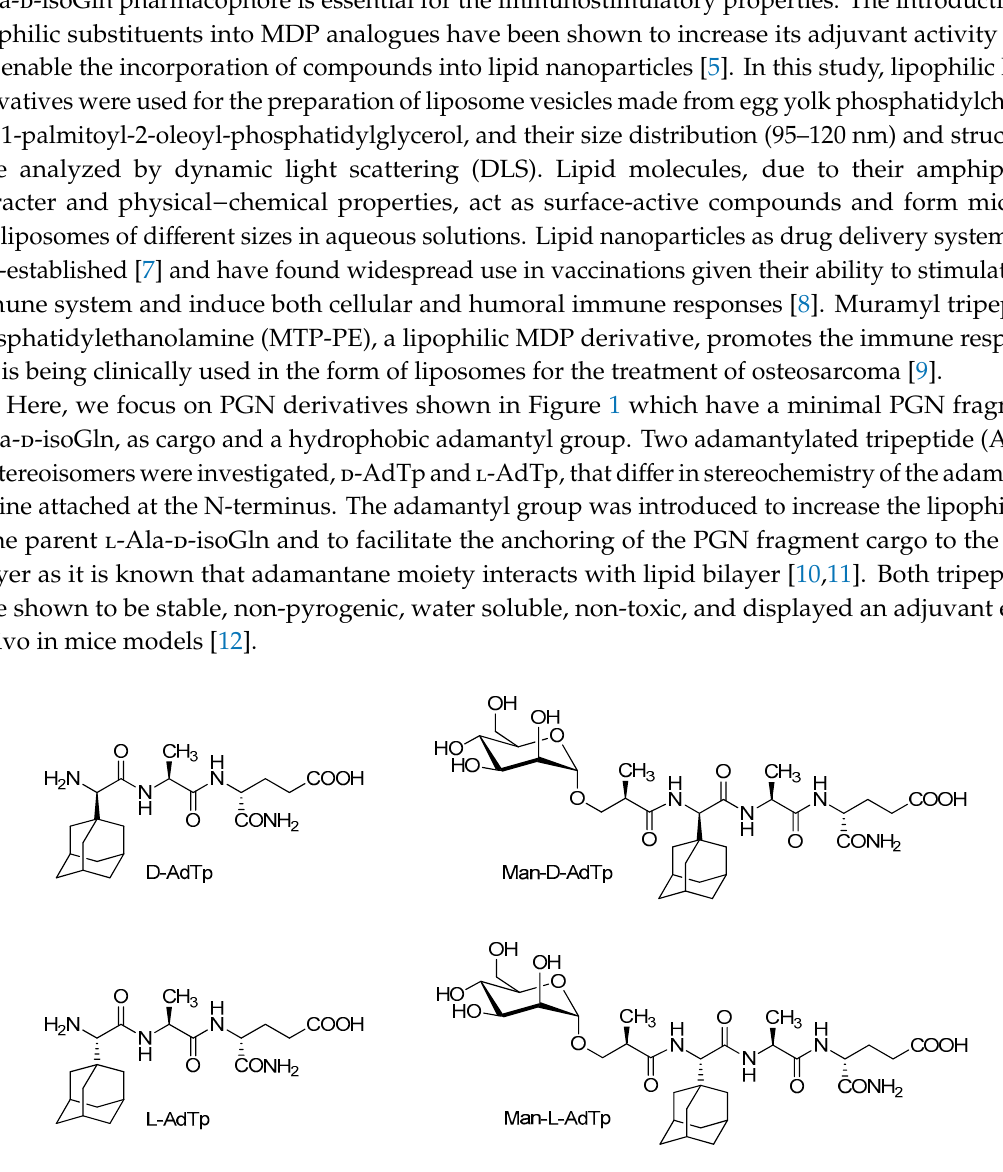
Figure 1. Chemical structures of investigated peptidoglycan (PGN) derivatives. D- AdTp: D -(adamant-